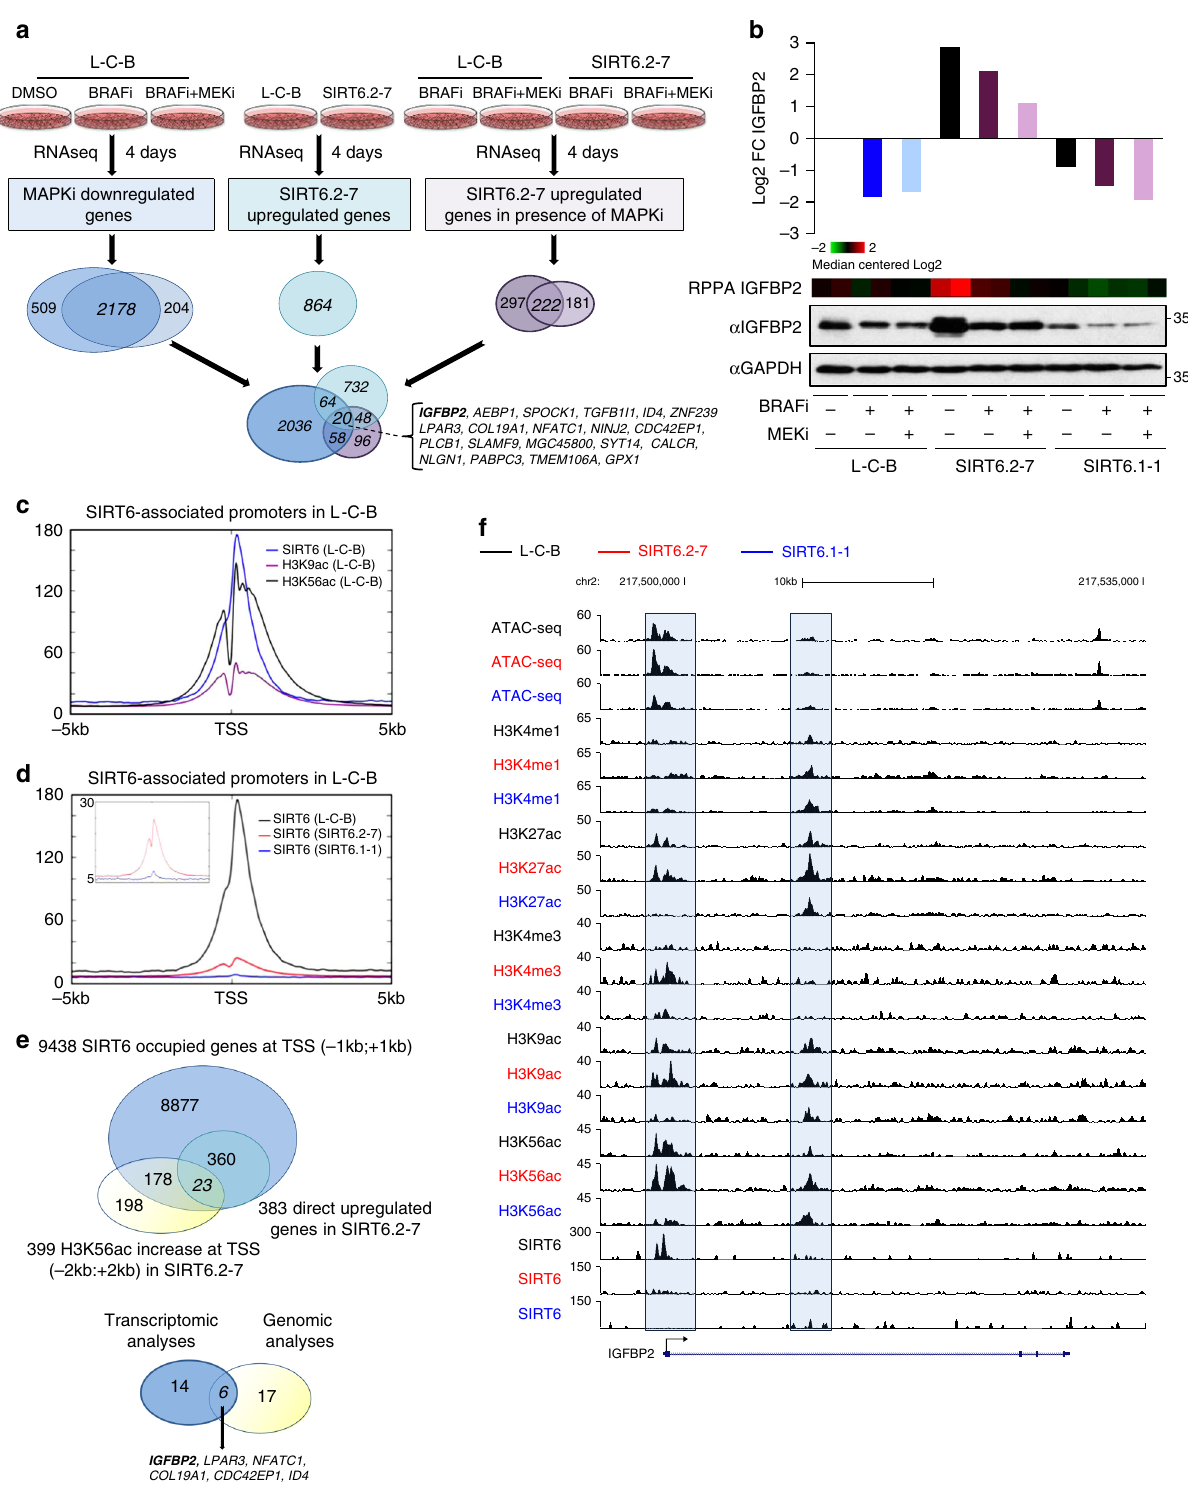
resistance to MAPKi upon SIRT6 haploinsuf fi ciency (Fig. 3a, Supplementary Data 2), some of which were validated by quan- titative RT-PCR (qPCR) (Supplementary Fig. 5f). Importantly, some of these genes have been implicated in resistance to BRAFi in melanoma 28,42 , reinforcing our strategy. Strikingly, however, the majority of these genes are down- regulated in SIRT6.1-1 cells (Supplementary Data 2). Consistent